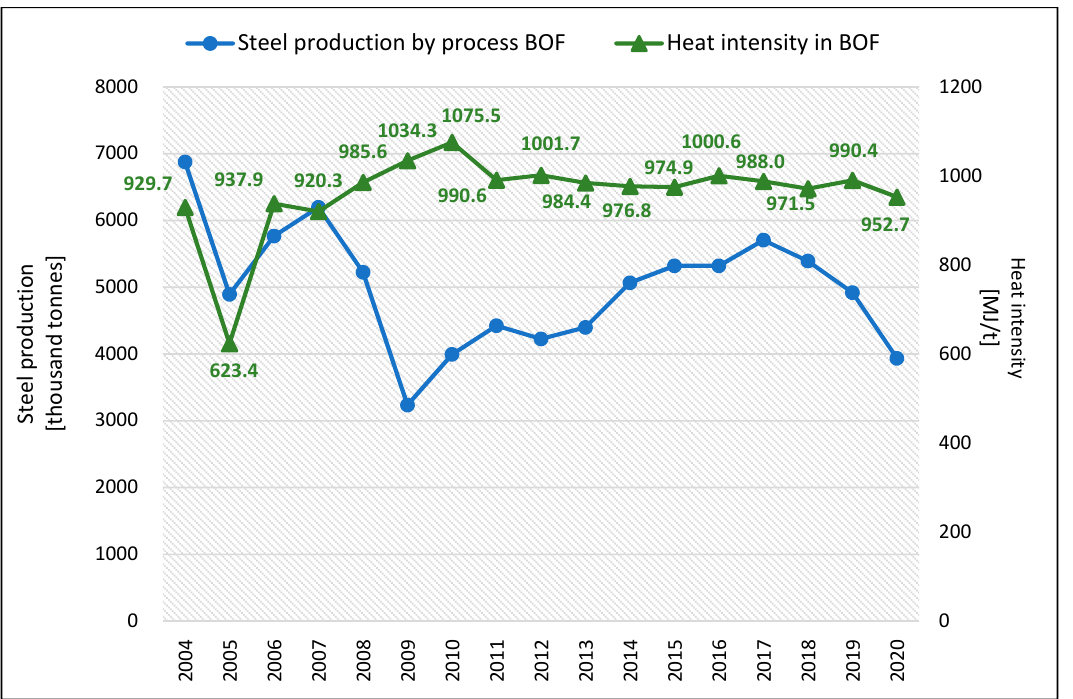
Figure 3. Heat intensity per 1 tonne of steel in the BOF process in Poland from 2004 to 2020. Source: Own elaboration based on data from [11].